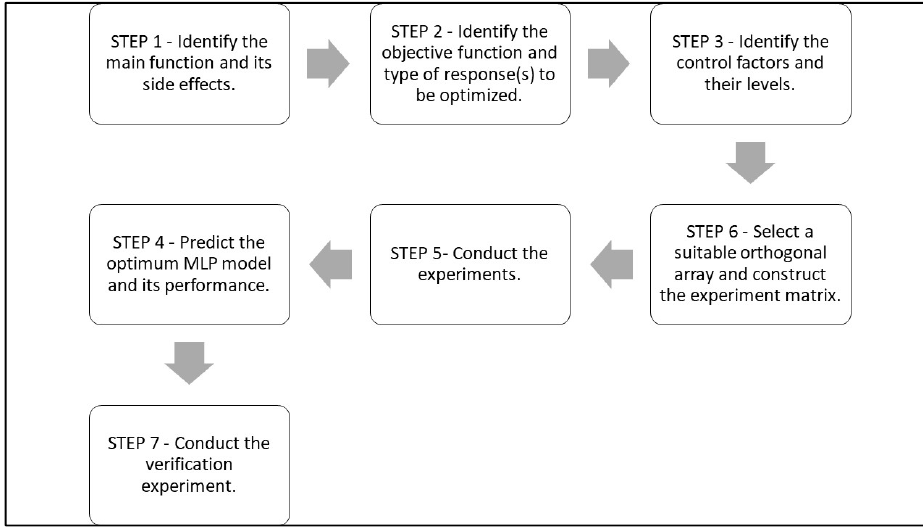
Figure 4. Flow chart of the Taguchi